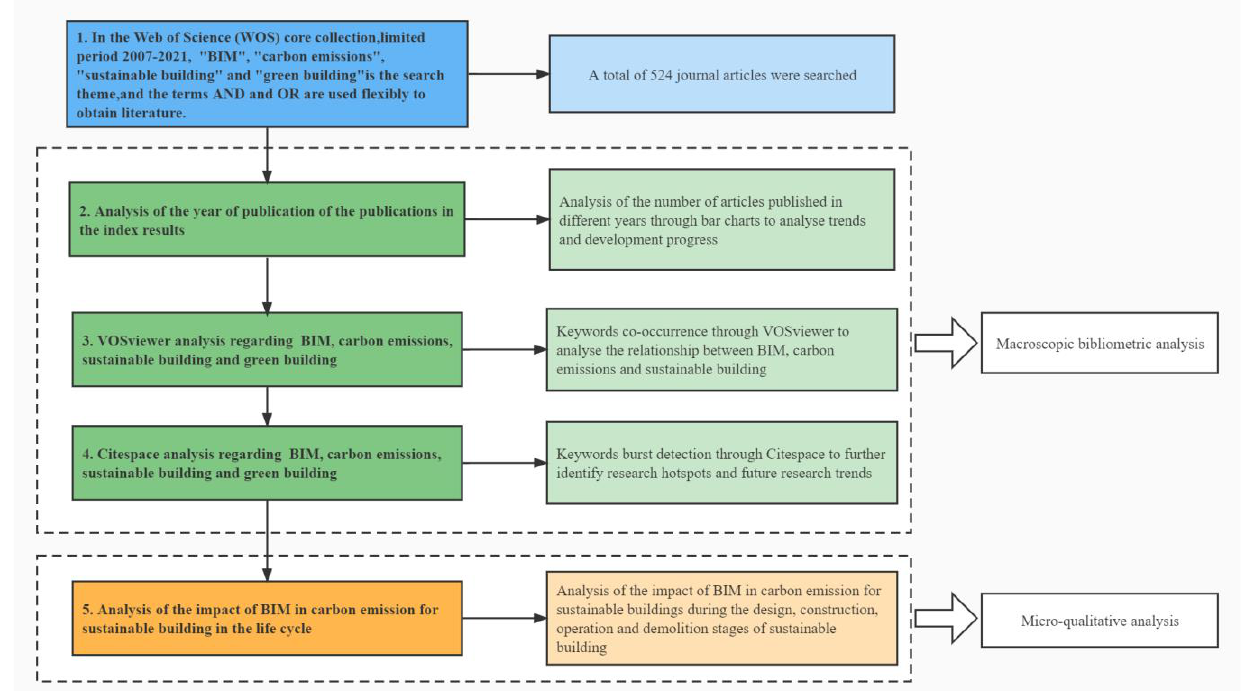
Figure 1. Research method flow diagram.